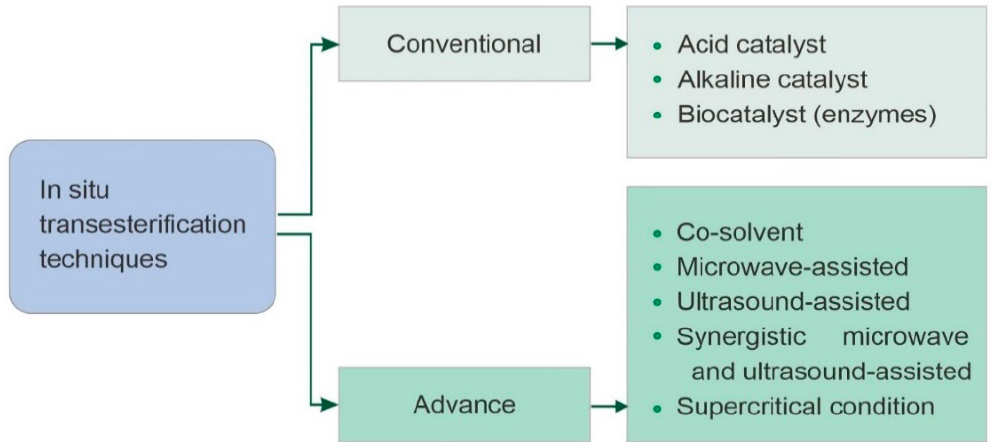
Figure 6. General classifications of in situ transesterification techniques (adapted from [30]).